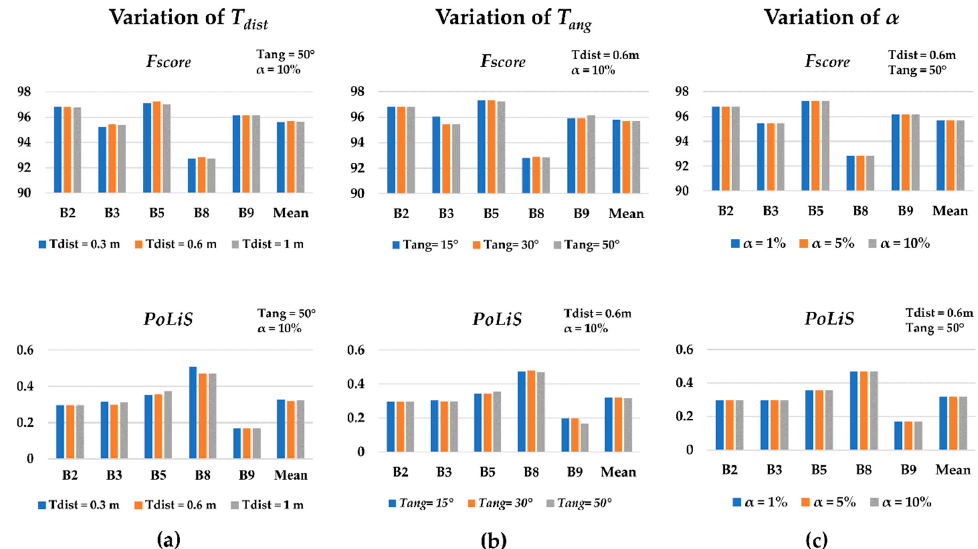
Figure 9. Quality parameters for buildings B2, B3, B5, B8, and B9, while varying T dist ( a ), T ang ( b ), and level of significance ( c ).